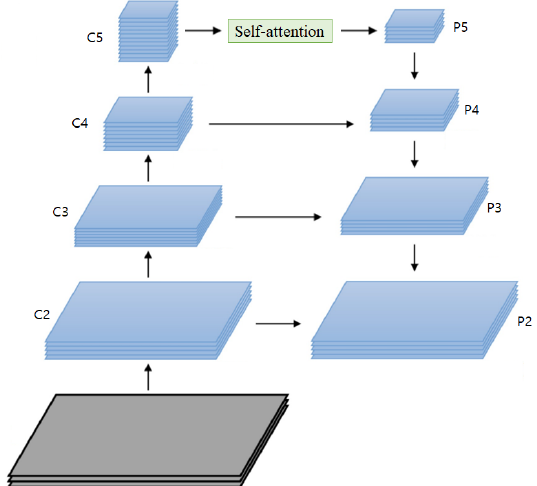
Figure 4. Feature pyramid networks (FPN) [15] with the self-attention module. The self-attention module is applied on the top of the backbone network. Global contexts are acquired by the self- attention module and propagated through the top-down pathway of the FPN. All FPN stages are influenced by the global contexts, which helps the RPN to generate better bounding